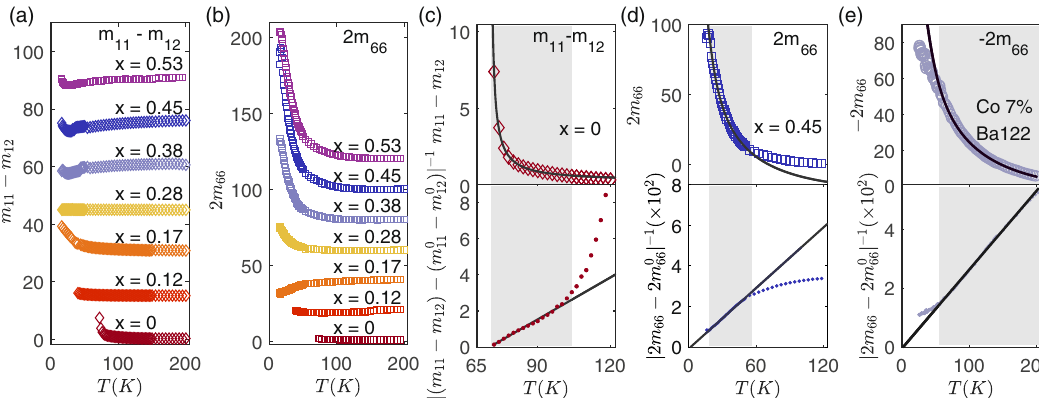
Fig. 2 Temperature and doping dependence of nematic fl uctuations of annealed Fe 1 + y Te 1 − x Se x . a Temperature and doping dependence of nematic fl uctuations in the B fi cient m − m 1 g channel, with elastoresistivity coef 11 12 , and b B 2 g channel, with 2 m 66 . For clarity, the elastoresistivity data for each doping are offset by 15 and 20 in a , b , respectively. c – e Temperature dependence of c m 11 − m 12 for x = 0, d 2 m 66 for x = 0.45 and e − 2 m 66 for Ba(Fe 0.93 Co 0.07 ) 2 As 2 . Lower panels show the inverse. Solid black curves are Curie – Weiss fi ts. The optimal fi tting range is determined by the greatest corresponding adjusted R-square value (see Supplementary Note 4). Shaded gray regions indicate the range of temperatures where the elastoresistivity coef fi cients follow a Curie – Weiss